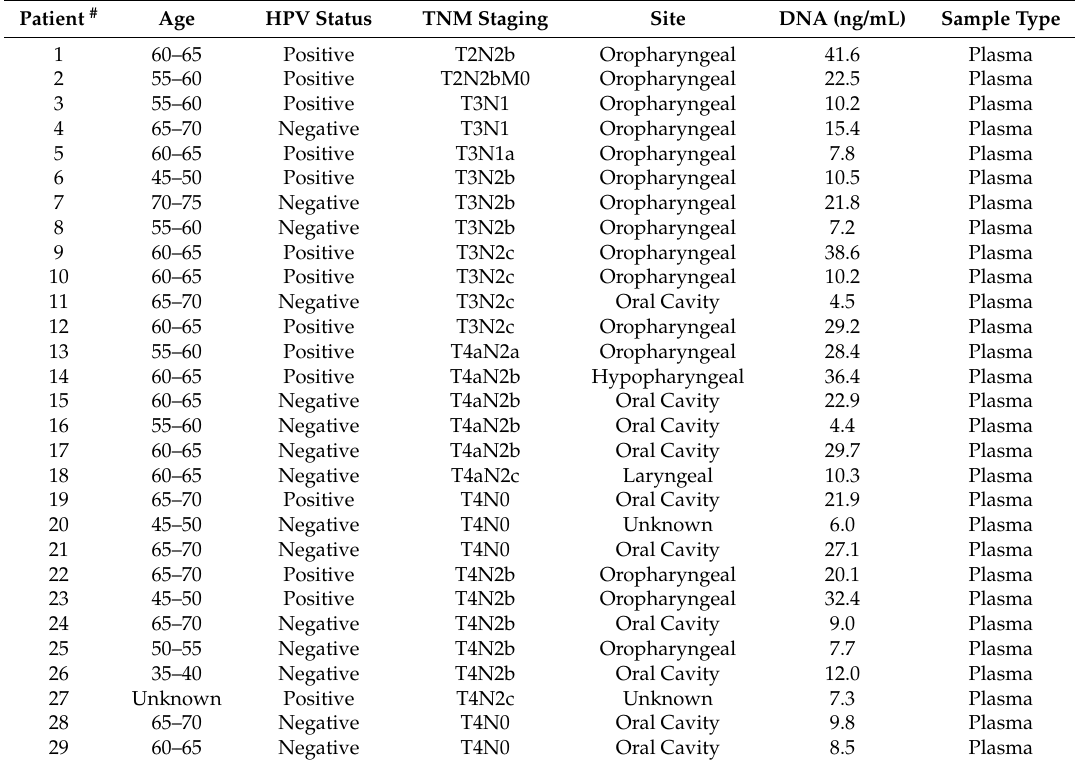
Table 1. Head and neck cancer patients ( n = 29) demographics